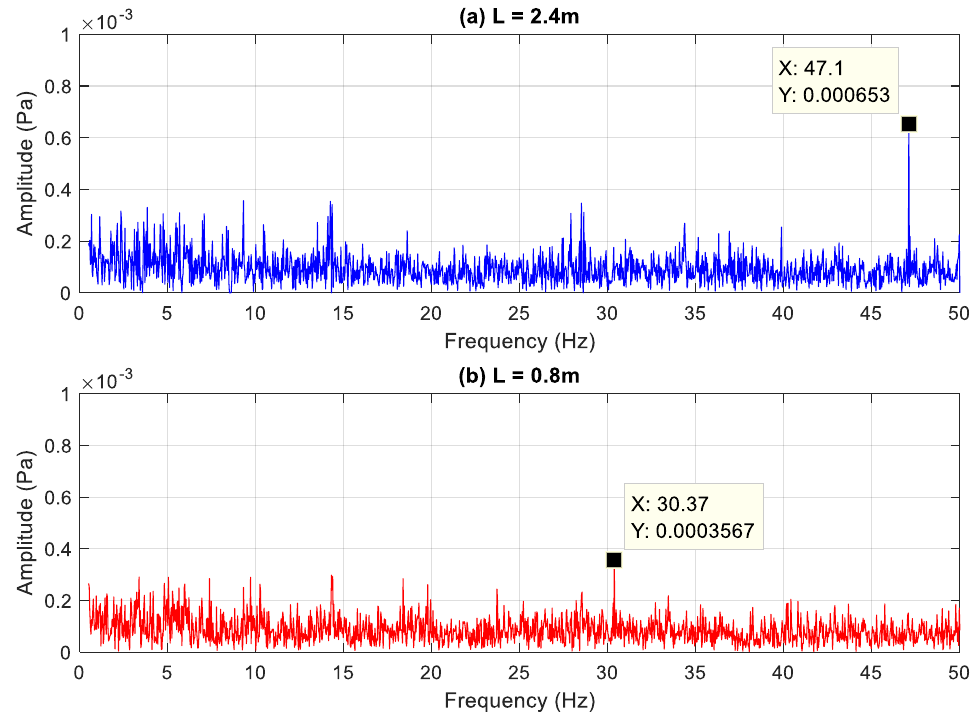
Figure 4. Spectrum of the acoustic signal from the meter for a belt linear speed of 2.4 m/s and for a belt tensile force of 40 kN: ( a ) idler spacing at 2.4 m; ( b ) idler spacing at 0.8 m.